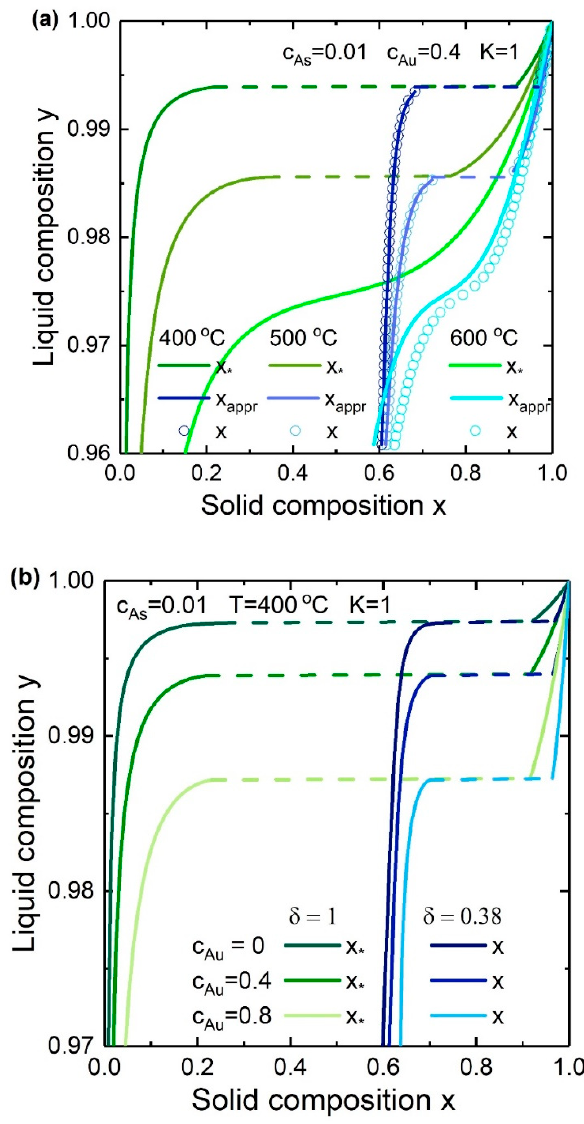
Figure 6. Liquid-solid composition dependences for In x Ga 1 − x As NWs at fixed K = 1, c As = 0.01, δ = 0.38, 1 ( a ) for di ff erent temperatures at fixed c = 0.4 and ( b ) for di ff erent Au / III concentration ratios at fixed T = 400 ◦C.